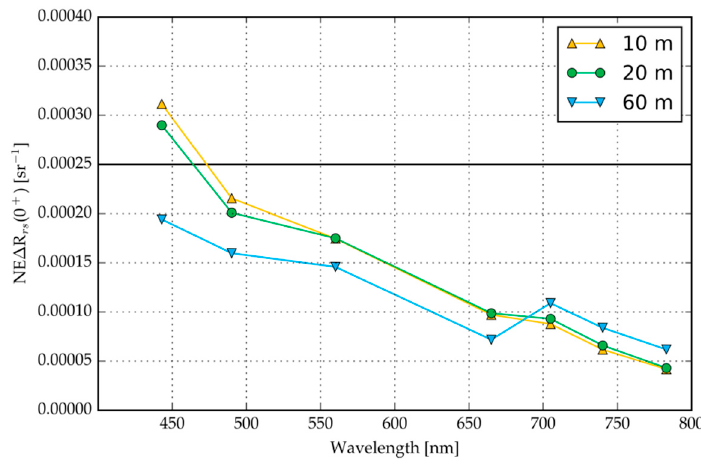
∆ R rsE for each band calculated for the MIP atmospherically corrected Figure 3. NE Δ R rsE for each band calculated for the MIP atmospherically corrected dataset. Figure 3. NE